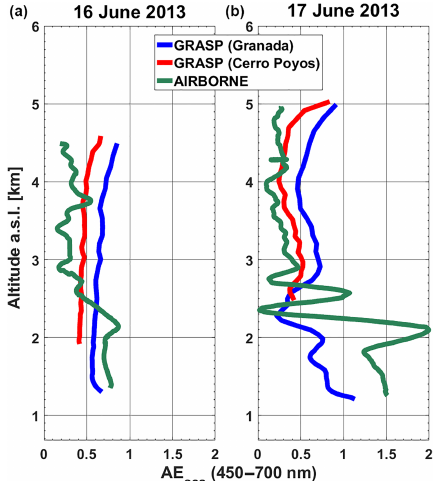
Figure 10. Scattering Ångström exponent (450–700nm) retrieved by GRASP at Granada (blue) and Cerro Poyos (red) and aircraft measurements (green) on 16 (a) and 17 (b) June